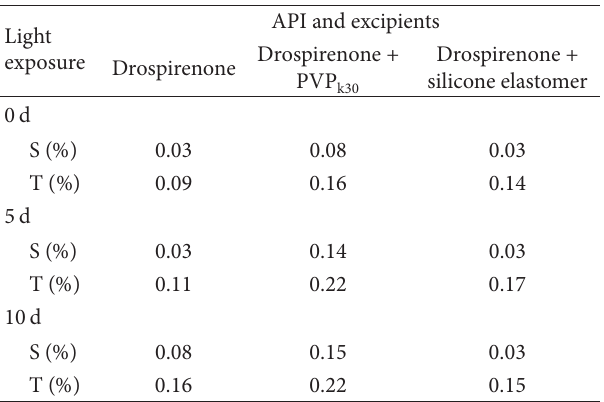
T 5: e results of API excipients compatibility testing under strong light exposure (4500